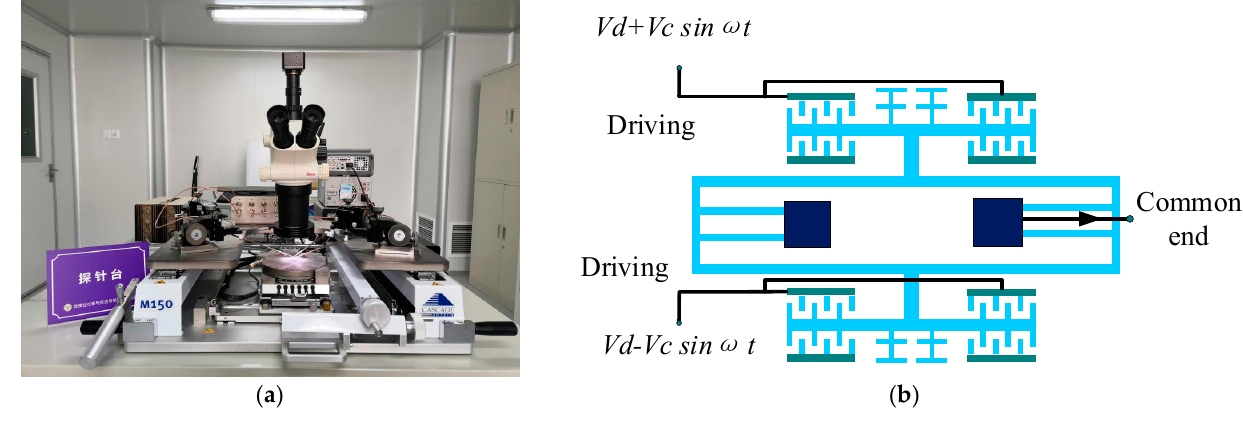
Figure 7. Open-loop test. ( a ) Probe station. ( b ) Accelerometer open-loop test pinout. All the accelerometers on the wafer were tested in the open-loop mode. The unloaded resonant frequencies of all the accelerometers were between 24 and 26 kHz. The test data of 10 accelerometers are shown in Table 2. Due to manufacturing errors, the resonant frequency of the resonator fluctuates, and there is a difference between the resonant frequencies of the two resonators of the same accelerometer. In general, the measured resonant frequencies of the fabricated accelerometer were basically consistent with the theoretical values.